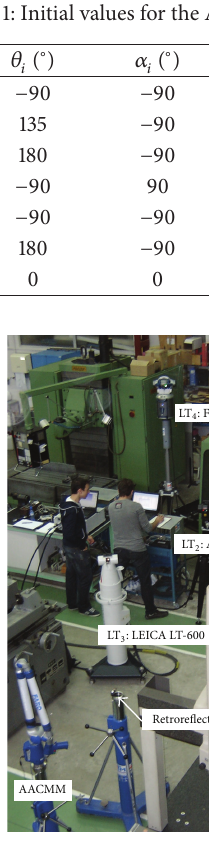
Figure 3: LTs and AACMM distribution used in tests.